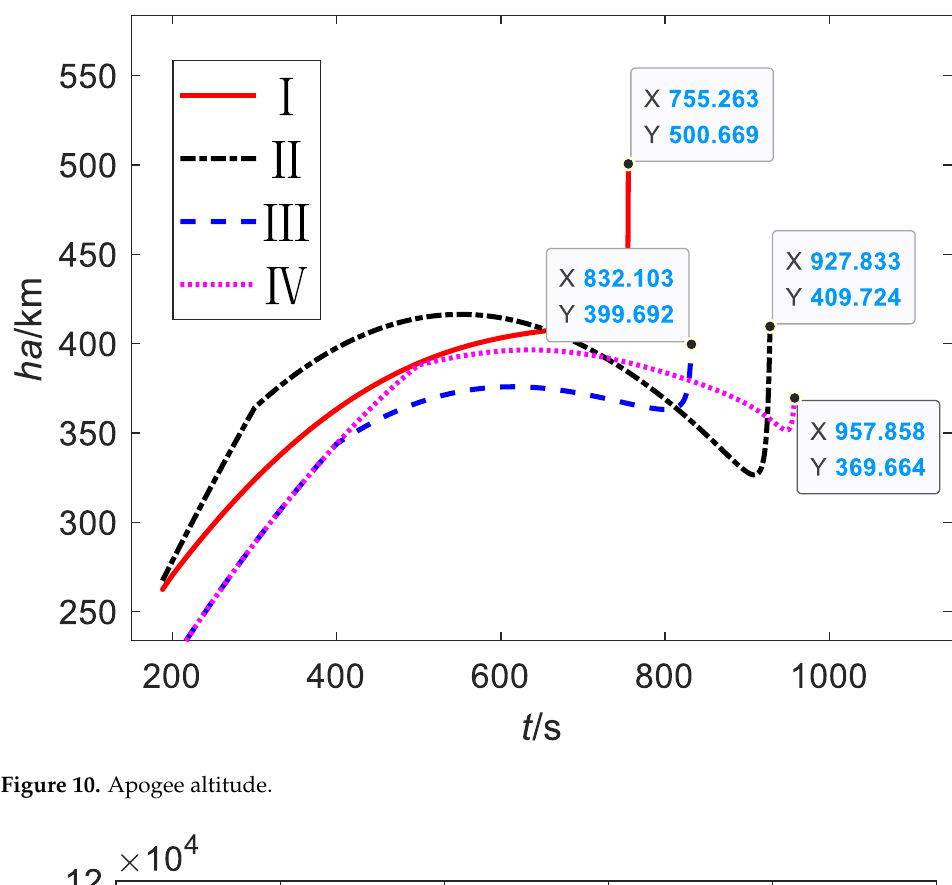
Figure 9. Perigee altitude.